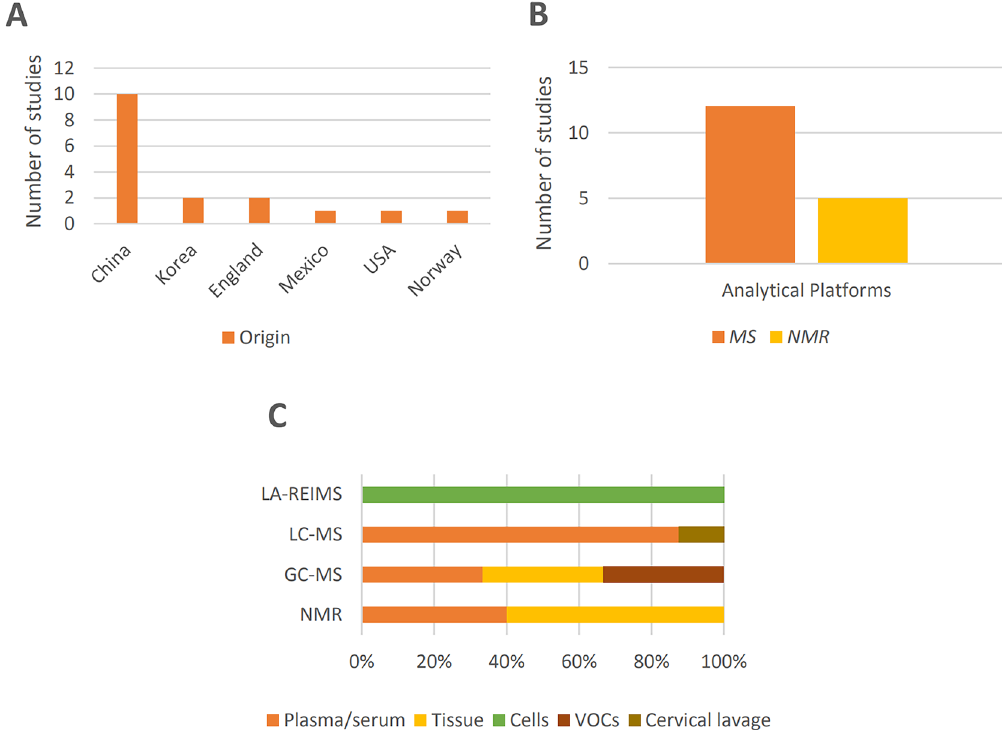
Figure S2 – General characteristics of the selected studies. A. Country of origin and number of studies. B. Analytical